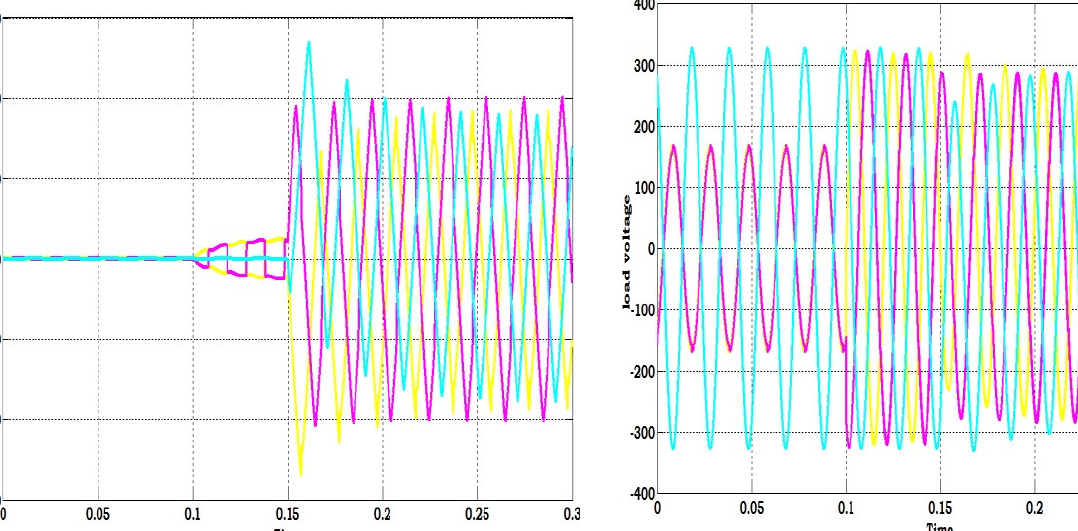
Figure 16. Waveform of Load